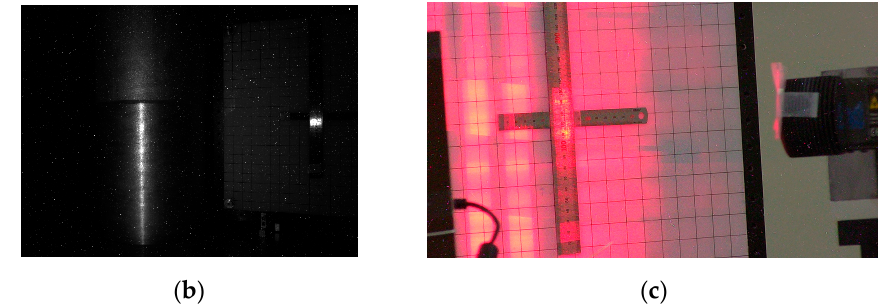
Figure 6. Experimental Data at 5H56M: ( a ) 3D Point Cloud; ( b ) Image of Camera; ( c ) Image of IP Camera.